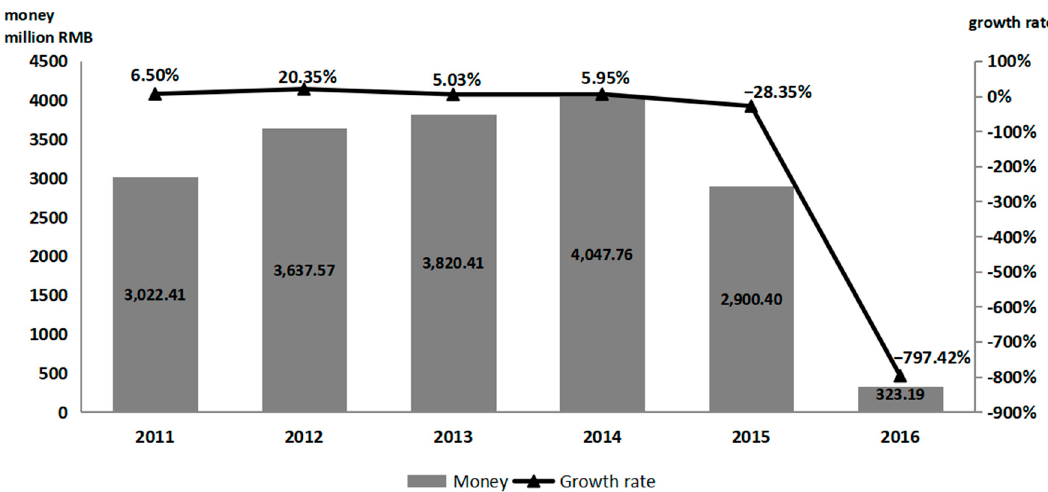
Figure 1. 2011–2016 Social Compensation Fee of Shandong Province.